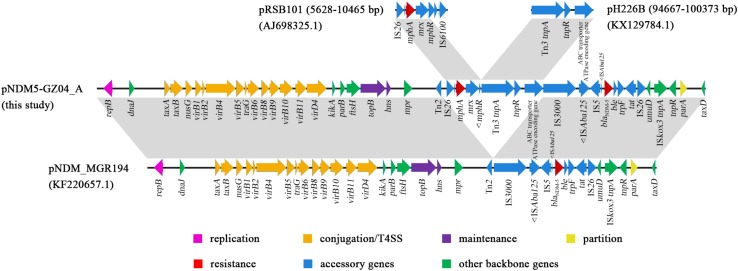
The comparative schematic diagram of plasmids pNDM5-GZ04_A, pNDM_MGR194, and fragments of pRSB101 and pH226B. The open reading frames are denoted by arrows. Regions with >99% identity among different plasmids are indicated by light gray.